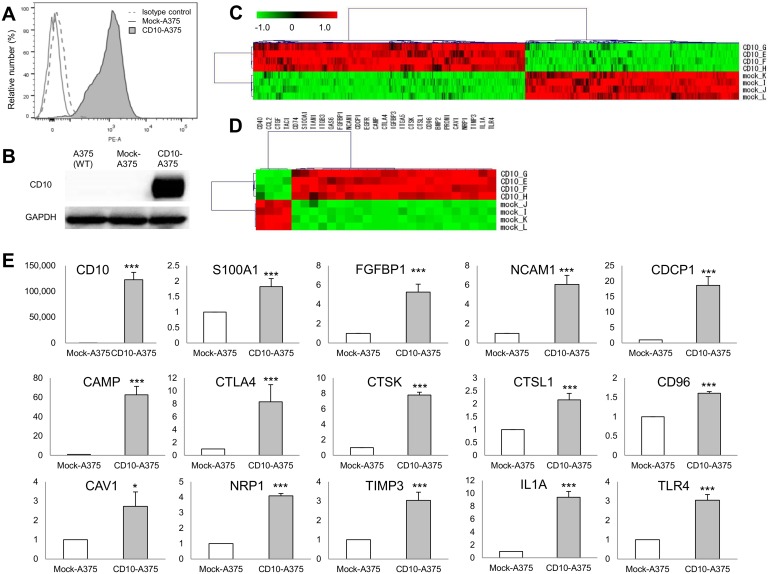
Establishment of CD10-A375 melanoma cells and gene expression profiles.(A) Stable transfection of CD10-A375 cells was confirmed by flow cytometry. After selection with G418, CD10-A375 or mock-A375 cells were examined for CD10 protein expression with PE-conjugated anti-hCD10 antibody. CD10-A375 exhibited marked surface expression of CD10 (gray shaded area), whereas mock-A375 did not (solid gray line). Isotype IgG control is shown with a gray dashed line. (B) Western blot analysis of CD10 and GAPDH in the wild type- and transfected- A375 cells. Successful transfection of CD10 was also confirmed in CD10-A375 cells by Western blot analysis. (C and D) Microarray analysis of gene expression in CD10-A375 vs. mock-A375 melanoma cells. (C) Heat map generated using MeV4.6 from the 1,247 probes of genes significantly differentially expressed between CD10-A375 and mock-A375 (n = 4 per group). A red color represents a higher-than-average standardized expression value, whereas a green color represents a lower-than-average one. Examples of differentially expressed genes are listed and sorted into major known functional categories in Table 2. (D) Heat map of the selected genes as shown in Table 2. (E) qRT–PCR validation analysis of representative genes that were significantly upregulated in CD10-A375 (n = 3). Each value was normalized for ACTB (β-actin), and the results are expressed as fold change over mock-A375. Primers used in the assay are shown in Table 2. *P < 0.05, **P < 0.01, ***P < 0.001; unpaired t test.